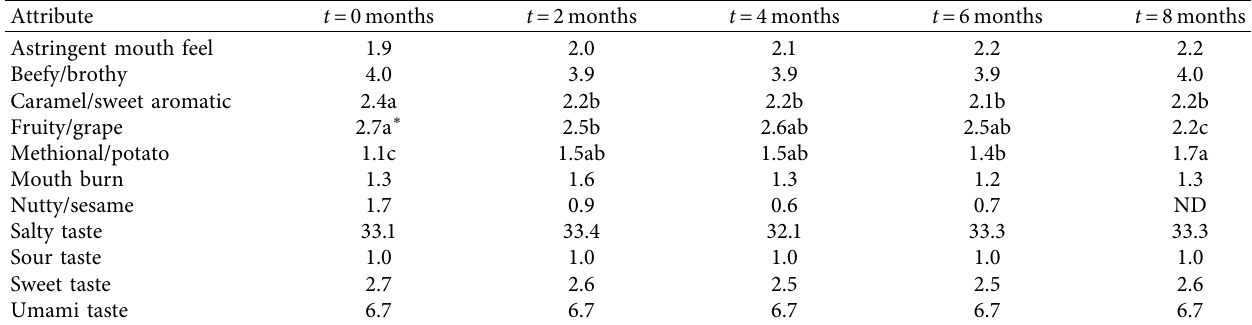
Table 2: Mean responses (0–15, where 0 � no response and 15 � extreme intensity) from trained panel analyses of SS samples aged for 8months at 30 ° C for each of the attributes denoted. Scores for saltiness exceeded the 0–15 range, reflecting an extremely high